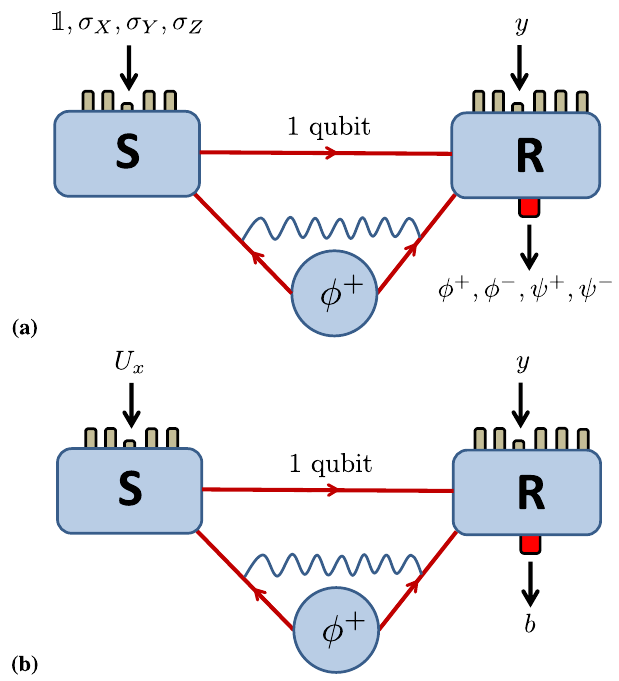
Fig. 1 | Entanglement-assisted quantum communication protocols. a Dense (cid:1) .Thesender codingscenario .Thesender(S)andreceiver(R)shareanEPRpair ∣ ϕ + selectsoneoffourPauliunitaries f 1 , σ X , σ Y , σ Z g ,appliesittoherqubitandrelaysitto the receiver who performs a measurement of both qubits in the basis of the four (cid:1) (cid:1) = 1 ffiffi = 1 ffiffi Bell states ∣ ϕ ± p ð ∣ 00 i ± ∣ 11 iÞ and ∣ ψ ± p ð ∣ 01 i ± ∣ 10 iÞ . From the outcome, the 2 2 sender ’ s two bit input can be recovered. b Generic sender-receiver scenario . The partiesagainshareanEPRpairandareallowedtocommunicateaqubit.Thesender can now select between any number of arbitrary unitary operations U x and the receiver can select between any number of arbitrary quantum